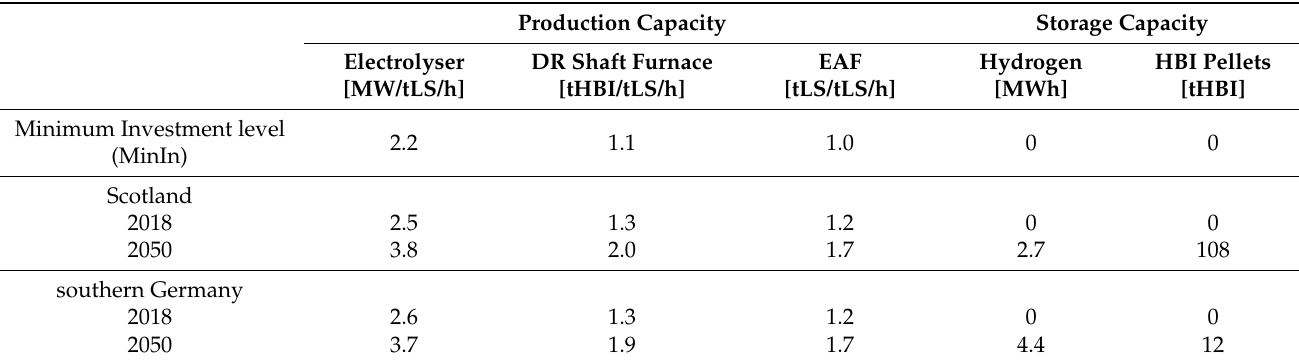
Table 3. The minimum investment levels in steel production capacities and for the production capacities and size of storages obtained from the modelling, for the two electricity price profiles and the two